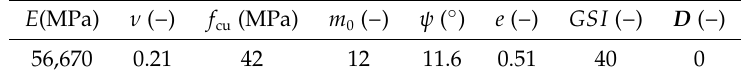
Table 4. Material parameters of Innsbruck quartz phyllite for the Hoek–Brown